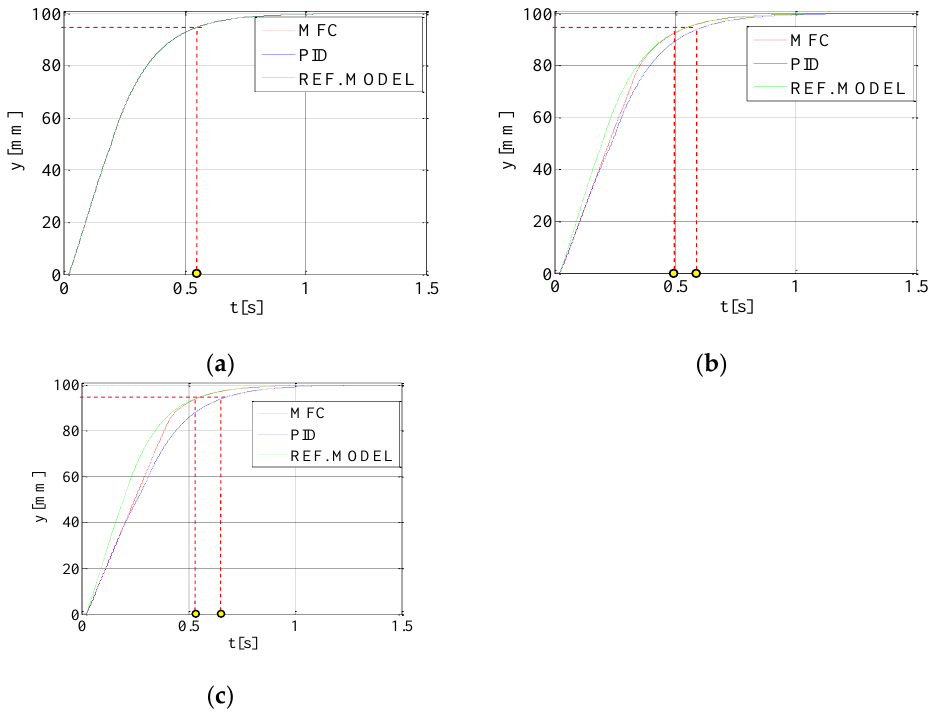
Figure 6. Load impact on drive step responses: ( a ) F = 0 N, ( b ) F = 5 kN, ( c ) F = 10 kN; p 0 = 12 MPa.